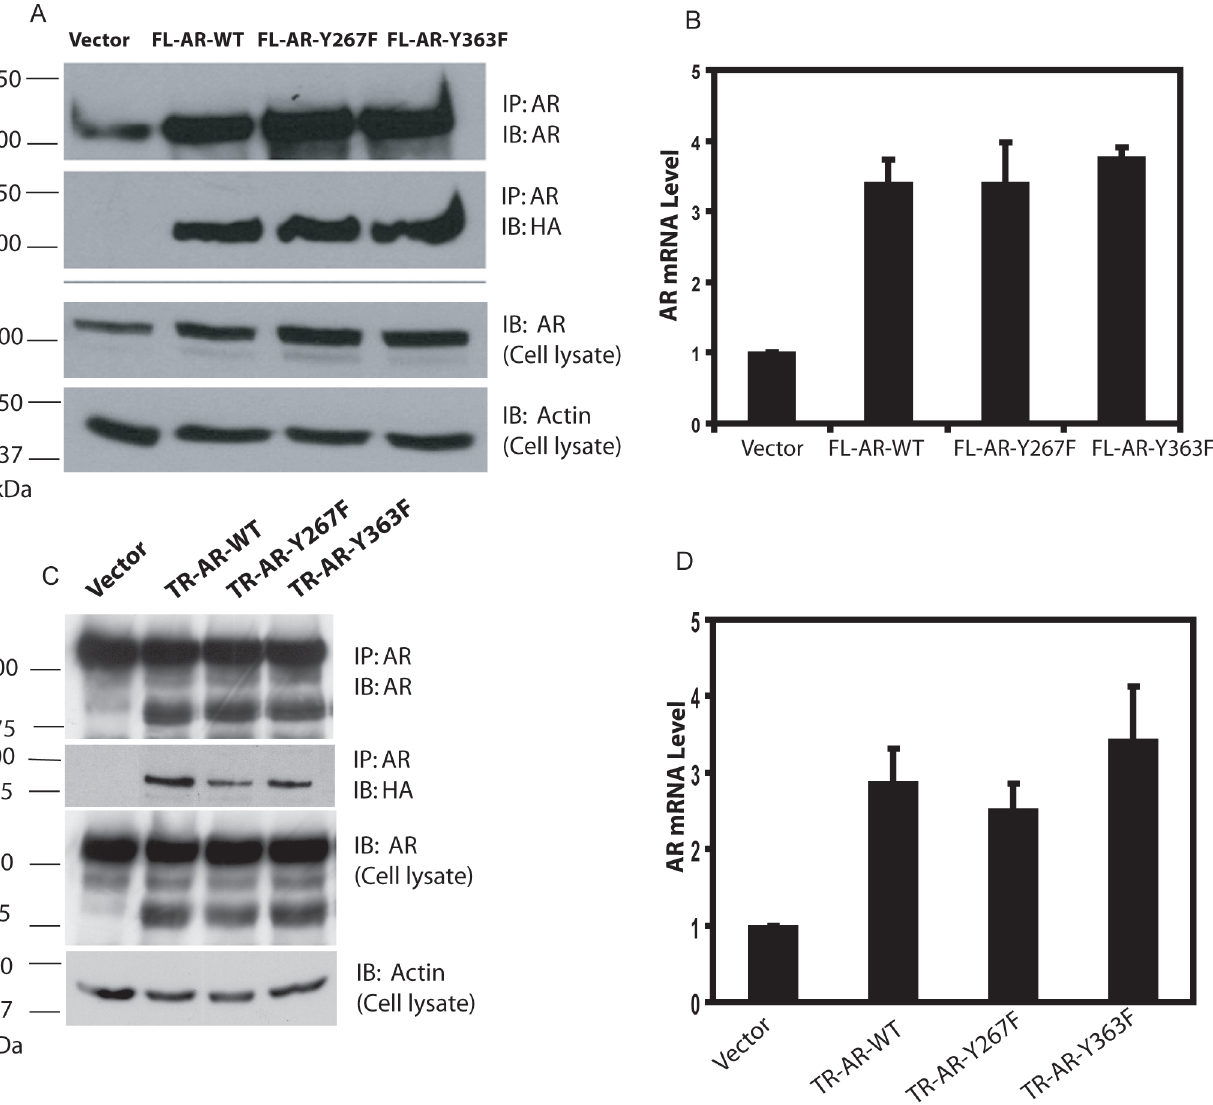
Fig 2. LNCaP cells stably overexpress full length or truncated AR or phosphorylation site mutants. LNCaP cells stably overexpressing AR constructs or vector control were derived by retrovirus-mediated transduction and antibiotic selection. (A) Lysates from LNCaP cells overexpressing full-length AR were subjected to immunoprecipitation with the AR antibody, followed by immunoblotting with the AR antibody or the epitope tag HA antibody, as indicated. Total cell lysates were also immunoblotted with the AR monoclonal antibody and actin antibody. (B) The mRNA levels of AR was determined by quantitative reverse transcription PCR of total RNA isolated from LNCaP cells stably overexpressing full-length AR. (C) Lysates from LNCaP cells stably overexpressing truncated AR were subjected to immunoprecipitation, followed by immunoblotting, as indicated. Total cell lysates were also immunoblotted with the AR monoclonal antibody and the actin antibody. (D) The mRNA levels of AR was determined by quantitative reverse transcription PCR of total RNA isolated from LNCaP cells stably overexpressing truncated